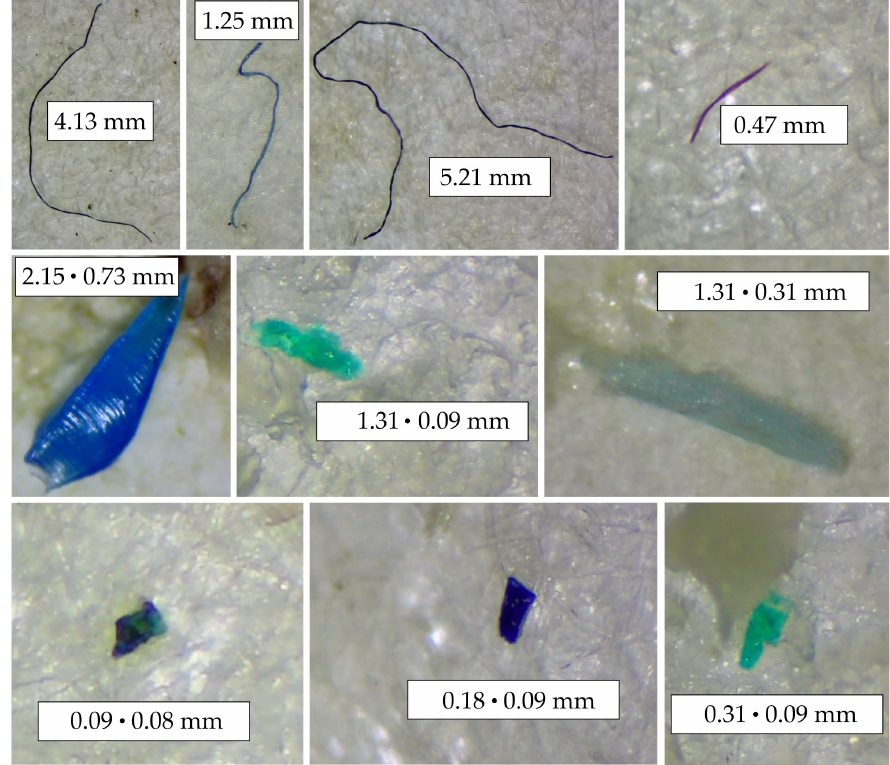
Figure 4. Images of MPs obtained by stereomicroscope coupled with a digital camera (description as 0.09 ⋅ 0.08 mm means max length × max width). 0.09 · 0.08 mm means max length × max